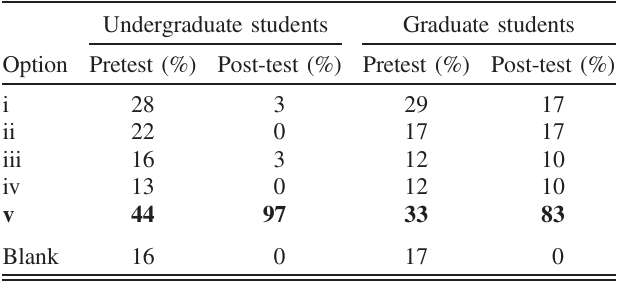
options as representations to form a good basis for the perturba- percentage of students who did not select any option in Q1 on the pretest and post-test for undergraduate students ( N ¼ 32 ) and graduate students ( N ¼ 42 ). The correct answer (option v) is in boldface